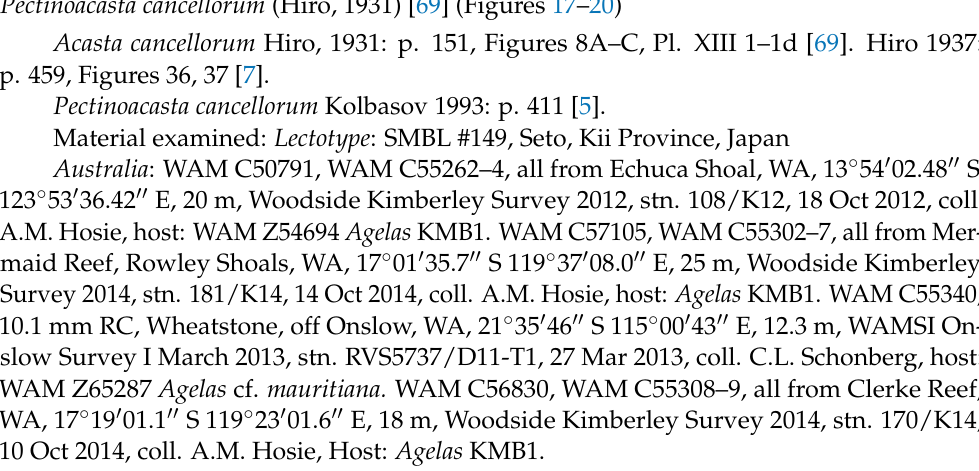
Diagnosis: Shell globose, parietes permeated with narrow longitudinal incisions extending from basal rim and small membranous windows at parietal junctions; externally surfaces studded with short sharp calcareous spines; internally longitudinal ribs extend below sheath and interlock with crenate basal rim. Scutum with longitudinal ridges crossing growth ridges. Tergum with setose, yellow chitinous cuticle covering external surface of carinal side of spur furrow, growth ridges crossed with longitudinal ridges giving a latticed appearance. Cirrus IV protopod with row of 6–7 teeth on anterior margin, anterior ramus basal segments with 1–2 recurved teeth on anterior margins. Description: Shell (Figure 17A–D,J,K), white or grey; orifice small relative to shell diameter, rim bluntly toothed. Parietes with longitudinal incisions extending from basal rim to over half parietal height, creating narrow, membrane-covered slits, incisions secondarily calcified in upper portions of parietes; external surfaces with numerous short, sharp, calcareous projections arranged irregularly, or in longitudinal rows where confined by incisions; parietes strongly curved toward orifice. Radii and alae not reaching basal rim, leaving small membranous windows between parietes; broad with striations perpendicular to oblique summits. Rostrum widest shell plate; internally, sheath with conspicuous horizontal growth lines; lower margin separated from internal parietal wall, extending to just above apical extent of parietal